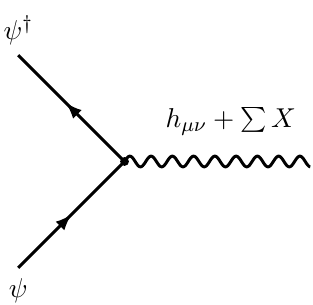
Figure 13 . The tower of HS particles P X must contribute to all gravitational interactions above Λ gr